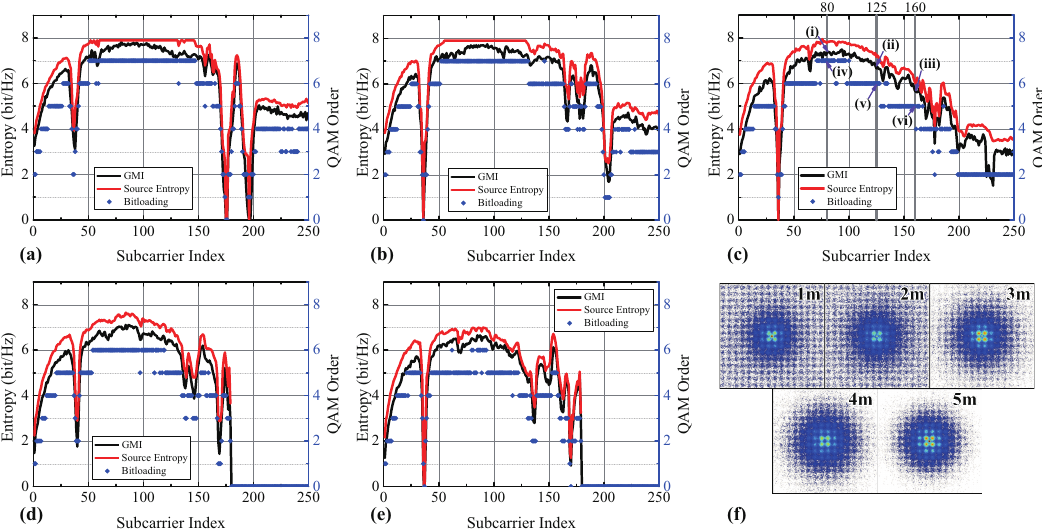
Figure 7. GMI, source entropy (SE) and the achievable bitloading order of the 250 subcarriers at the calibration point ( a ) 1 m, ( b ) 2 m, ( c ) 3 m, ( d ) 4 m, ( e ) 5 m; and ( f ) the overall received PS bitloading constellation at a distance from 1 m to 5